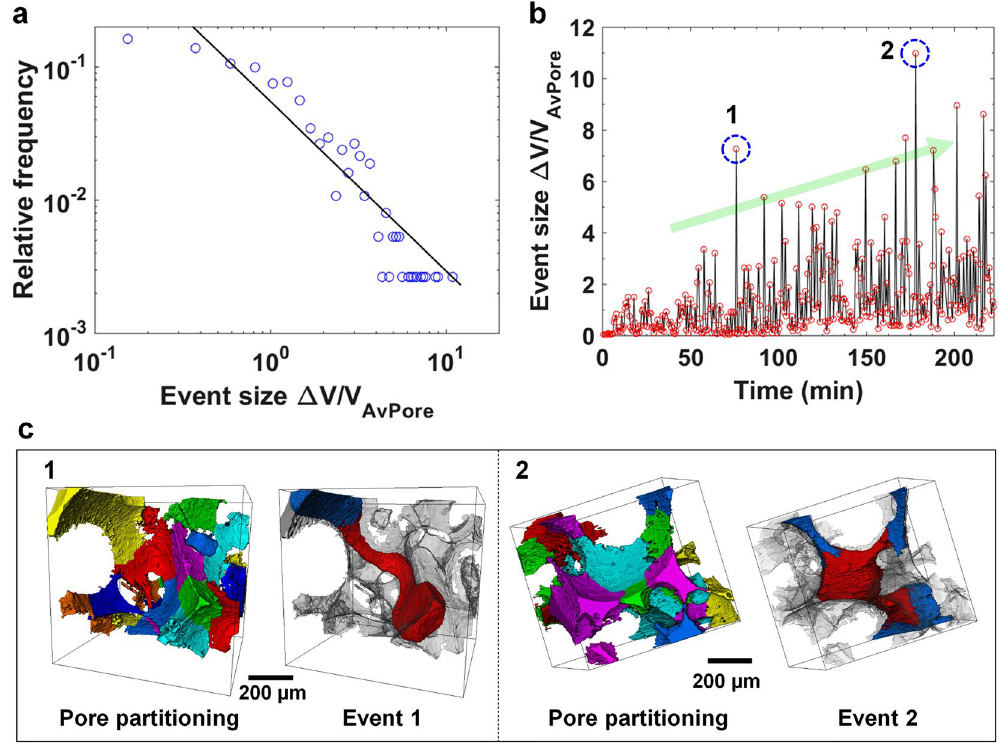
Figure 6. Pore-filling events. ( a ) A distribution of pore-filling (with brine) event volumes normalized by the average pore volume during imbibition. Here, only the largest event in consecutive tomographic images is presented. The line is a power-law fit, the exponent of which was calculated by a least absolute residual robust fitting algorithm. The smallest event size (the first data point) was excluded in data fitting. ( b ) The normalized size of pore-filling events as a function of time. ( c ) Pore-partitioned images showing subsets where event 1 and 2 (dashed blue circles in ‘Fig. 6b’) took place. Different colors in pore-partitioned images represent individual pores. In the event (1 & 2) images, red shows the locations where the pore emptied (oil was displaced by brine) after an event (obtained from subtracting consecutive images) and blue shows the new locations of the oil phase after an event. The complete pore space is rendered semi-transparent for effective